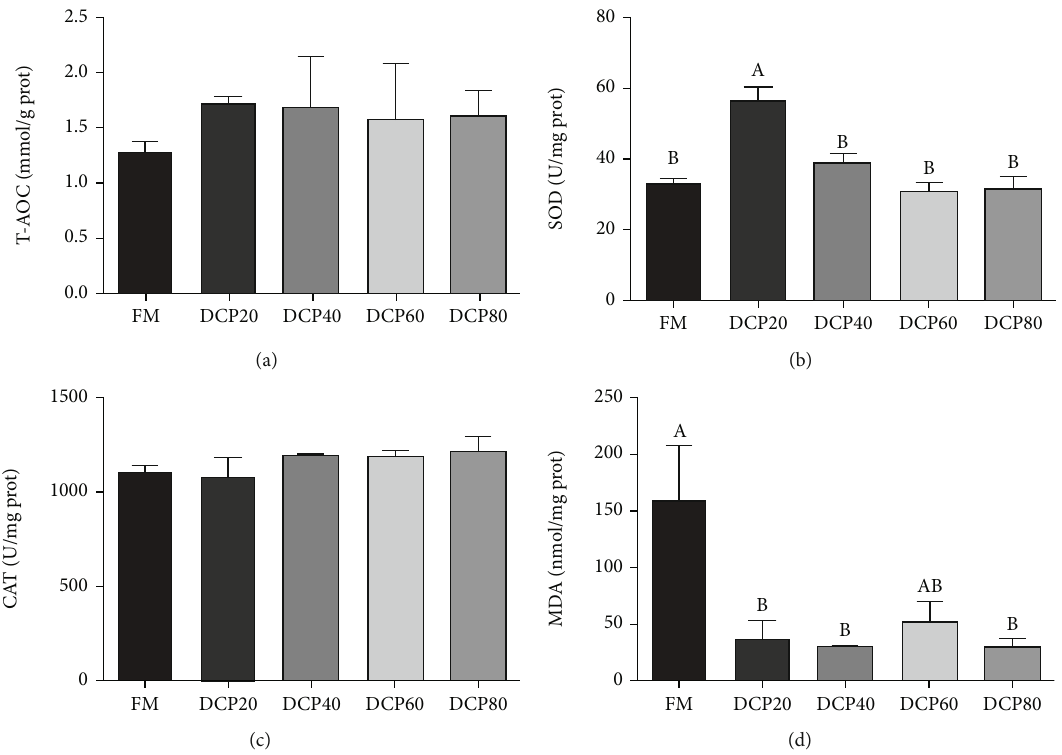
Figure 4: E ff ect of degossypolized cottonseed protein on hepatic antioxidant capacity of juvenile fed the trial diets ( means ± SEM, n = 3 ). T- AOC: total antioxidant capacity; SOD: superoxide dismutase; CAT: catalase; MDA: malondialdehyde. No repetition of letters in the equal index means signi fi cant di ff erences ( P < 0 : 05